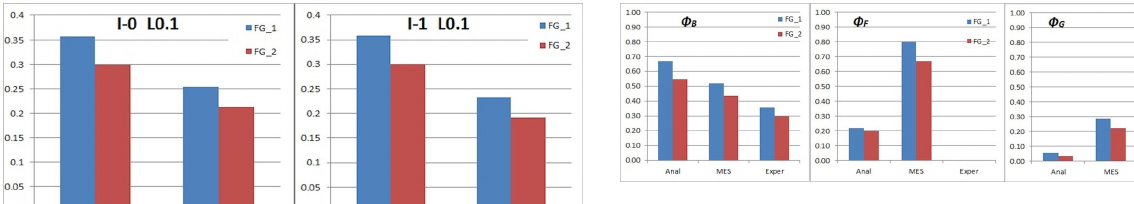
Figure 21: Listing of the safety factors calculated analytically and numerically as well as experimentally determined